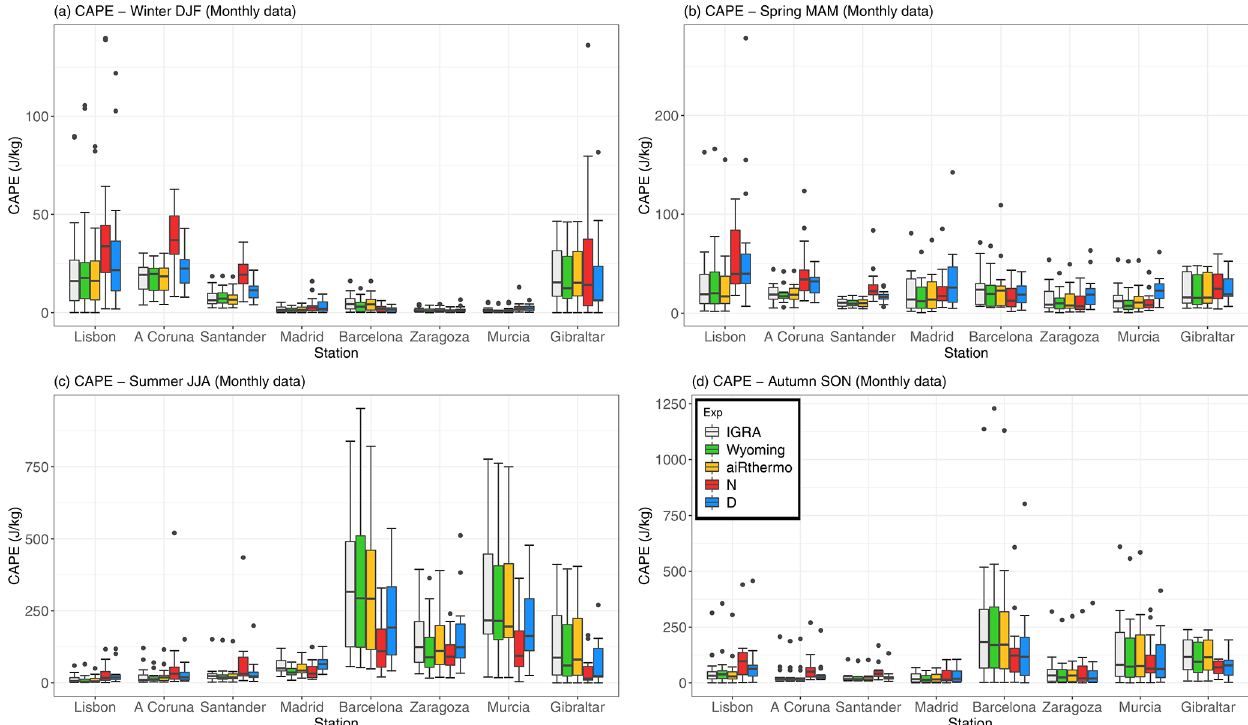
Figure 6. Same as Fig. 5 but for CAPE.